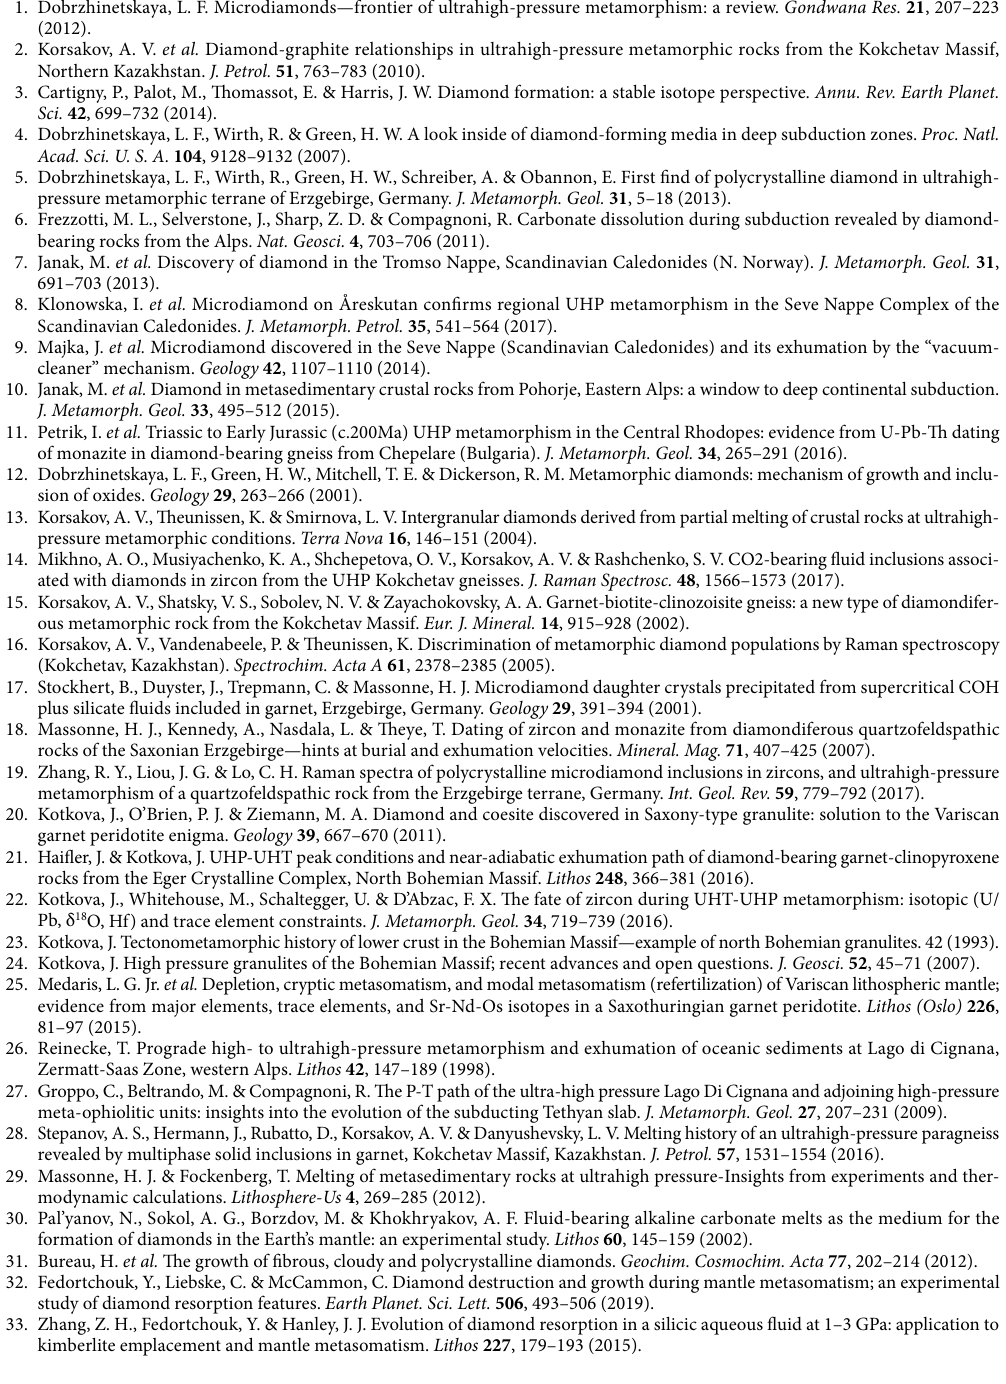
Table S1) when calibrated against a synthetic diamond (SYNAL, with δ 13 C = − 23.9‰ 67 ), demonstrating that a graphite reference material of this type can be used with confidence to determine δ 13 C in